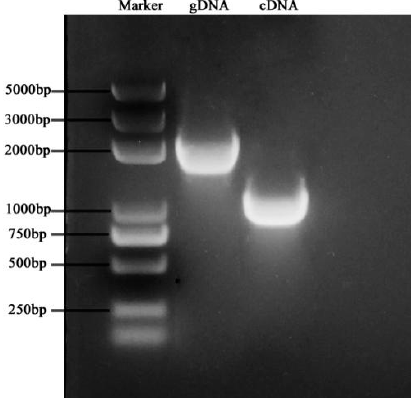
Figure 7. The agarose gel electrophoresis of cDNA and the gDNA and PCR product of